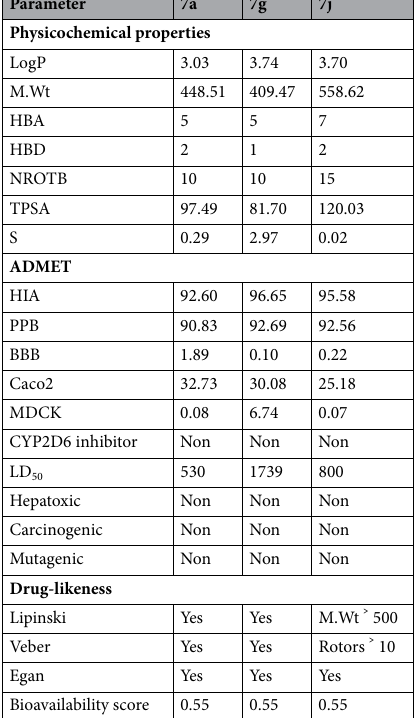
Table 6. In silico prediction of physicochemical properties, ADMET and drug-likeness of selected Passerini